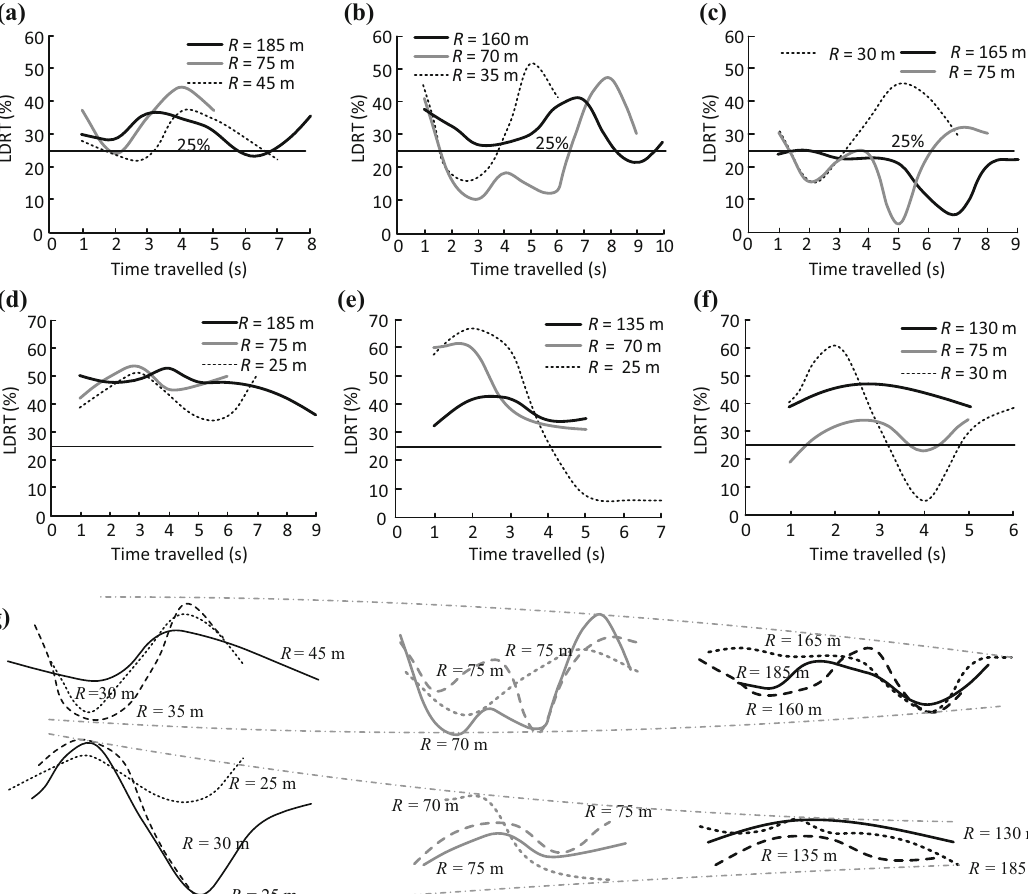
Fig. 8 LDRT profiles: ( a ) driver #1, left bends; ( b ) driver #4, left bends; ( c ) driver #7, left bends; ( d ) driver #1, right bends; ( e ) driver #4, right bends; ( f ) driver #7, right bends; ( g ) clustering of LDRT profiles based on the curvature